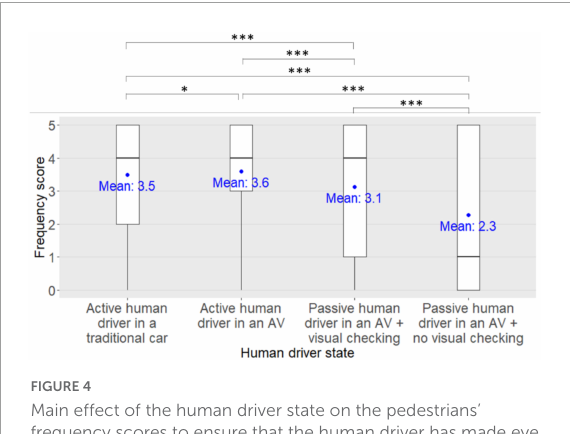
FIGURE4 Main effect of the human driver state on the pedestrians’ frequency scores to ensure that the human driver has made eye contact in order to take an effective crossing decision. *: pFDR < 0.05, ***: pFDR <